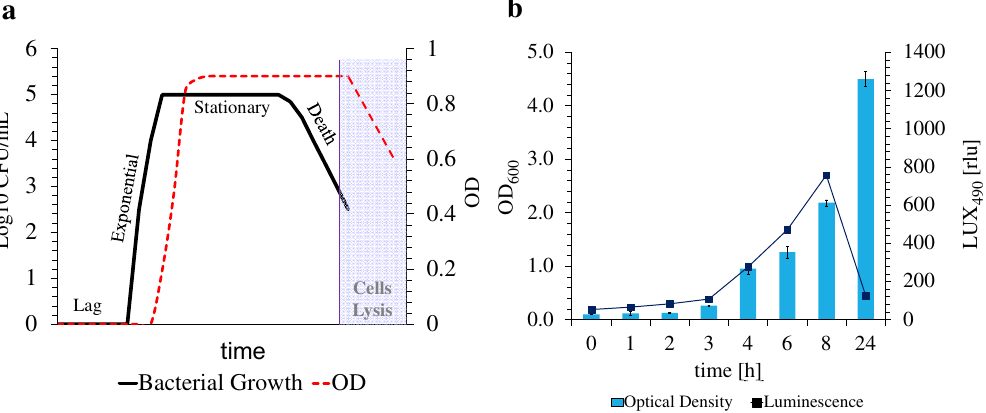
Figure 3. Typical bacterial growth curve and its correlation with OD measurements ( a ) adapted from [51]. Obtained bacterial growth curve and correlation with the recorded luminescence, emitted by luminescent E. coli Lux ( b ).